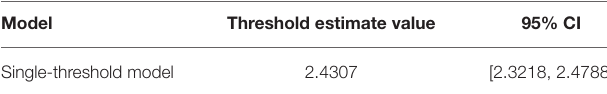
TABLE 9 | Threshold effect estimates and CIs. TABLE 10 | Parameter estimation